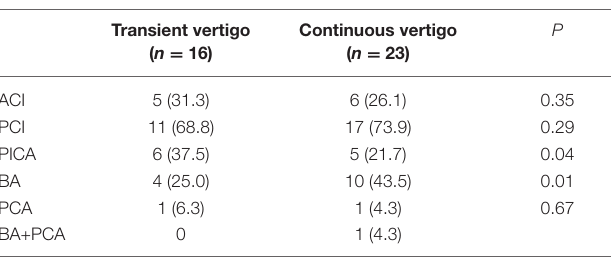
TABLE 1 | Analysis of infarct lesions.